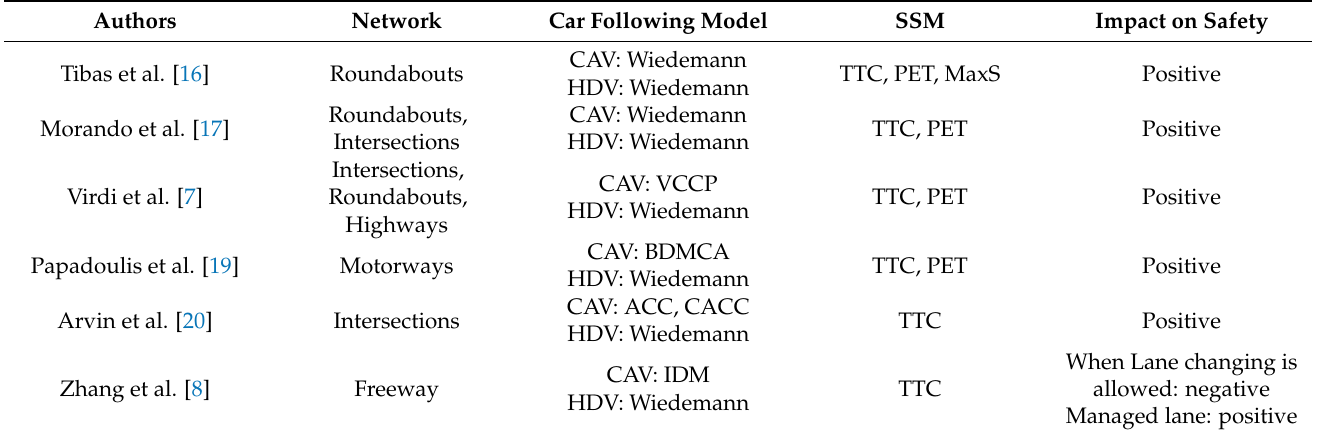
Table 1. Summary of studies (MaxS = the maximum speed of each vehicle during the conflict event, PET = post encroachment time, BDMCA: bidirectional decision-making control algorithm, SSM = Surrogate Safety